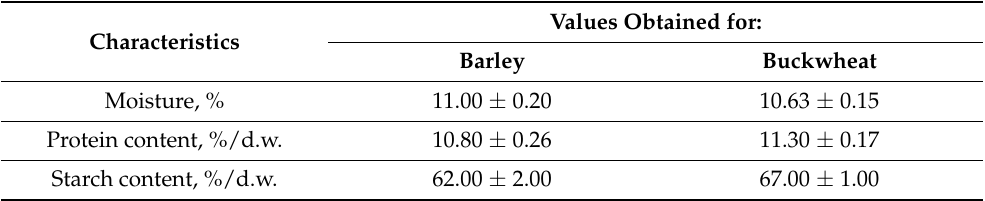
Table 3. Results of the physico-chemical evaluation of the unmalted barley and buckwheat samples used in the experiments.